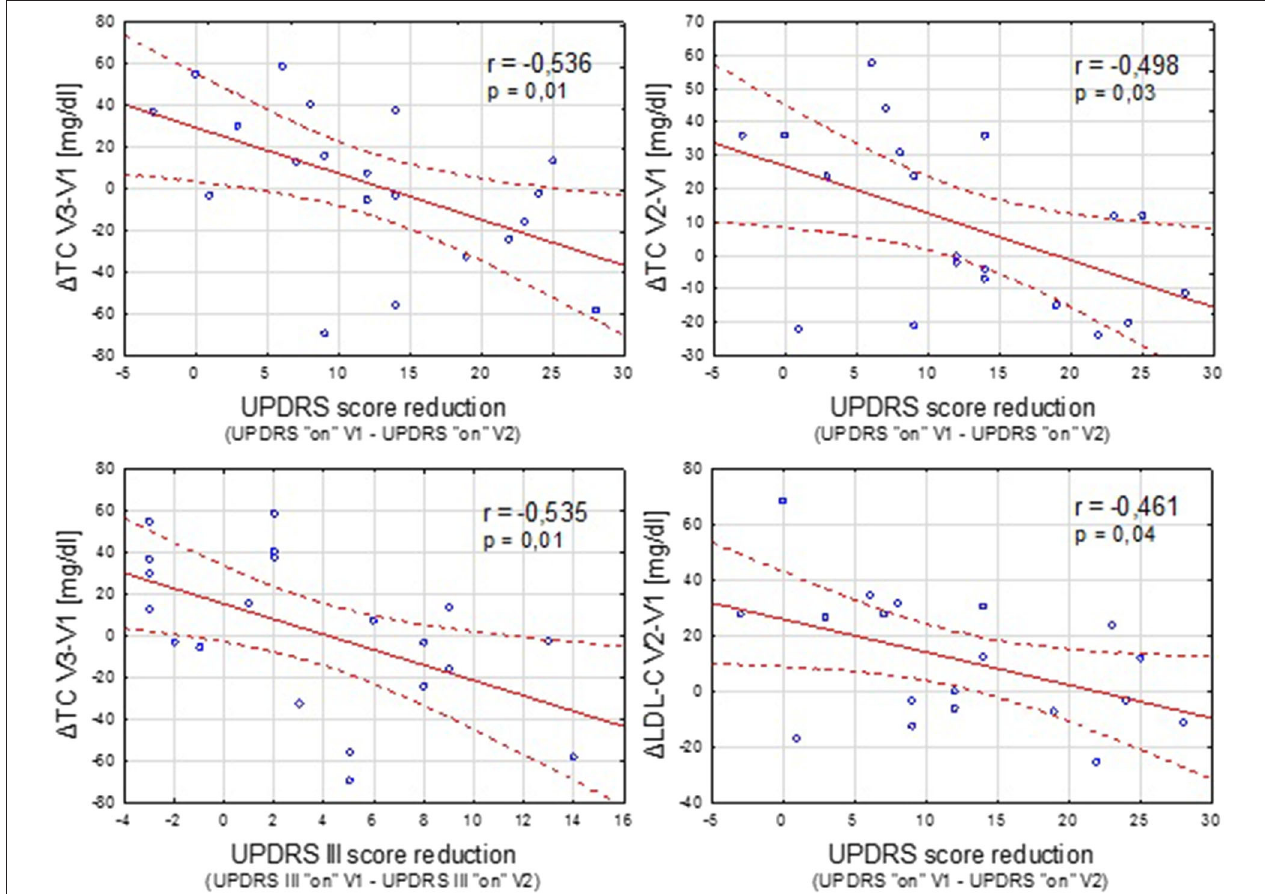
FIGURE 2 | Negative correlation between the clinical improvement after STN-DBS (expressed as reduction in UPDRS “on” and UPDRS III “on” scores between the time points V1 and V2) and increase in the TC and LDL-C concentration.